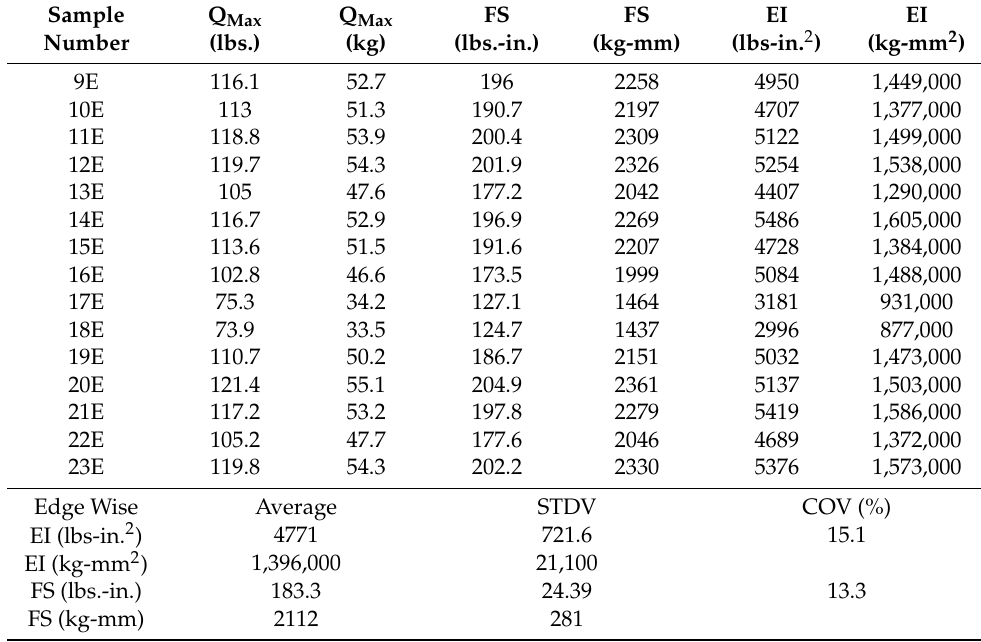
Table 2. Maximum Load at failure, Strength, and stiffness of Edge Wise Strips tested in bending.